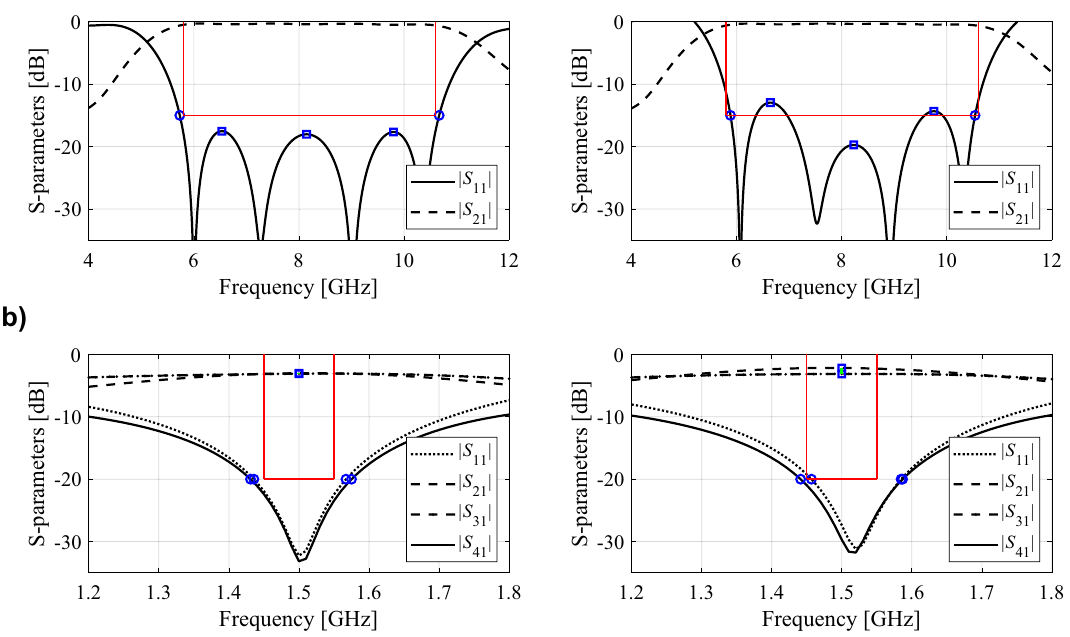
Figure 2. Exemplary features points: ( a ) S-parameters of a bandpass filter, characteristic points refer to − 15 dB level of return loss characteristic along with its local in-band maxima; the features allow for assessing if | S 11 | meets the matching conditions within the following band: 5.9 GHz to 10.6 GHz; ( b ) coupler’s S-parameters and the features referring to − 20 dB level of | S 11 | and | S 41 | characteristics (o), as well as | S 21 | and | S 31 | at the intended operational frequency 1.5 GHz ( ◻ ); the features permit to assess meeting the design requirements within the 100 MHz bandwidth around 1.5 GHz, and maximum power split error equal to 0.5 dB at this frequency. Designs fulfilling and infringing the specs are shown in the left- and right-hand-side panels,